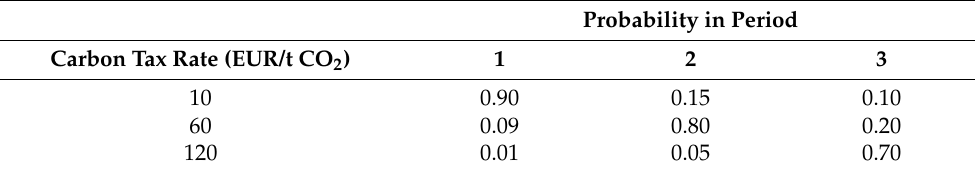
Table 4. Probabilities of the CO 2 tax in three